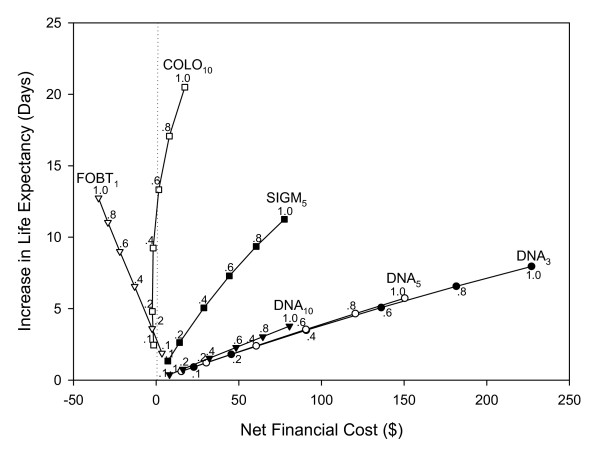
Sensitivity analysis regarding compliance to screening tool (0.1, 0.2, 0.4, 0.6, 0.8, and 1.0). Abbreviations: DNA3, stool DNA testing every 3 years; DNA5, stool DNA testing every 5 years; DNA10, stool DNA testing every 10 years; FOBT1, fecal occult blood testing every year; SIGM5, sigmoidoscopy every 5 years; COLO10, colonoscopy every 10 years.